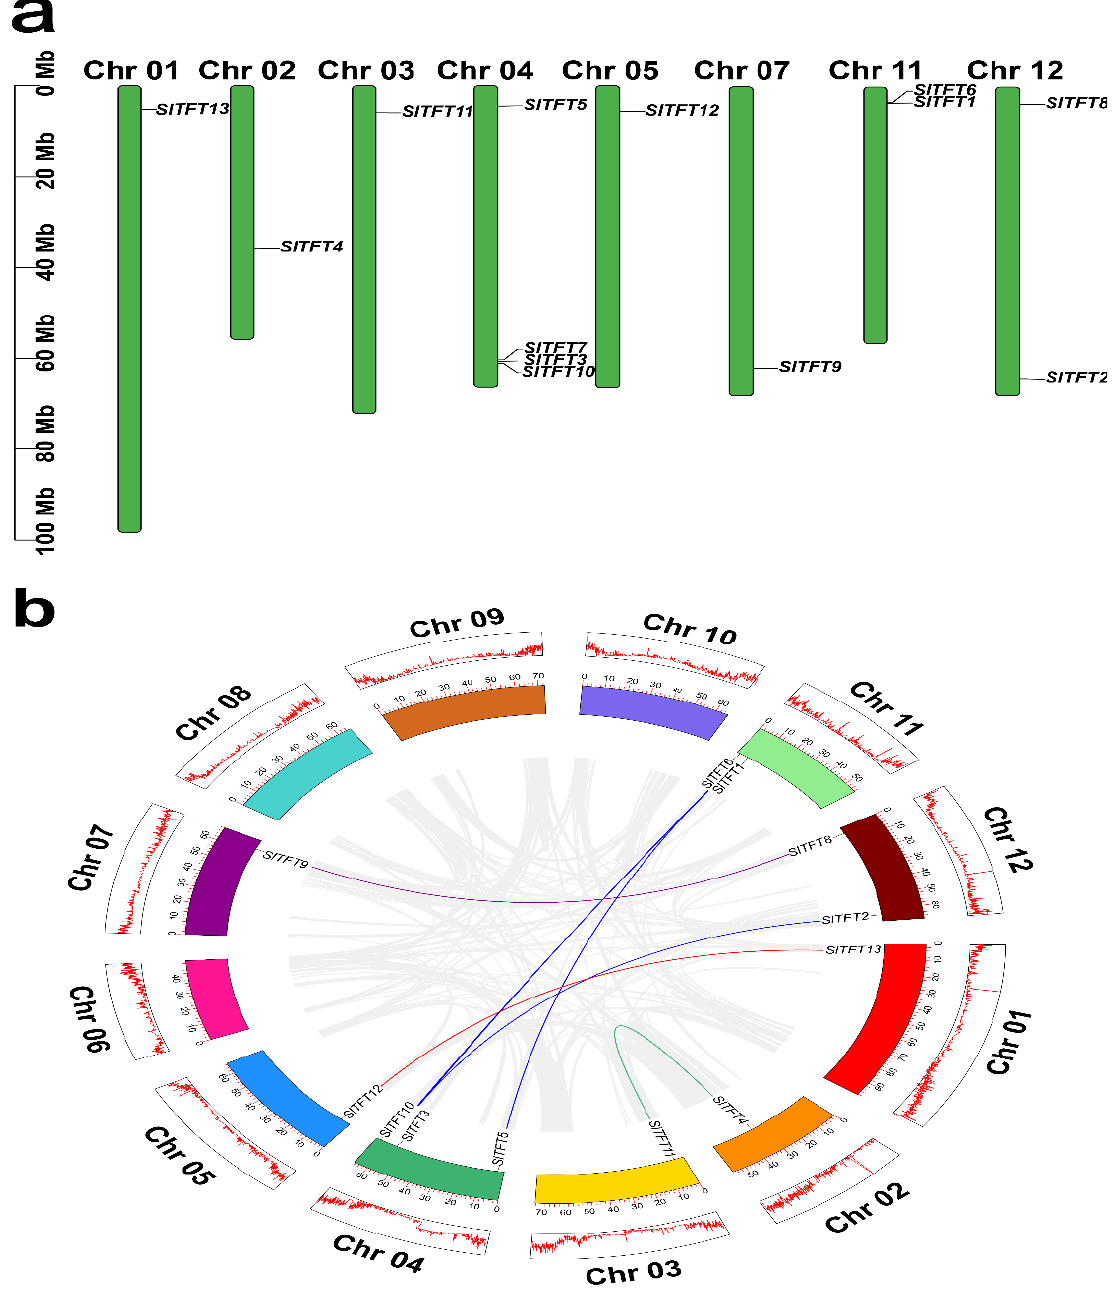
Figure 4. Chromosomal localization and gene duplication events in SlTFTs . ( a ) Distribution of genes on tomato chromosomes. The green rectangular squares represent chromosomes with specific chromosome numbers and the location and number of SlTFTs distributed on the chromosomes, with a scale of chromosome lengths on the left. ( b ) Duplicate pairs of SlTFTs in tomato. From outside to inside, the first circle is the chromosome number and density, and the second circle is the ideogram of the chromosome, with the scale on top indicating the coordinate position of the chromosome. Different colored lines indicate synteny pairs of SlTFTs , while gray lines indicate synteny pairs of all tomato genes.